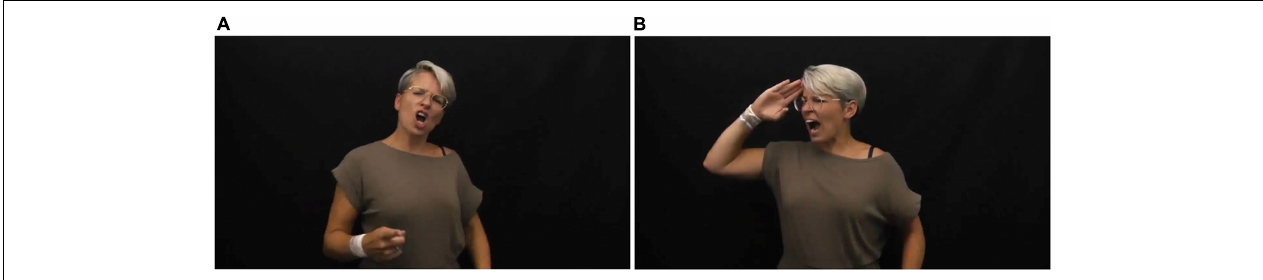
FIGURE 2 | Embodied role-shift/perspective-taking— (A) Drill sergeant facing toward the audience and (B) Recruit facing downstage-right, in Muse’s Pyscho (Stolk: Pyscho—Muse, 2020).